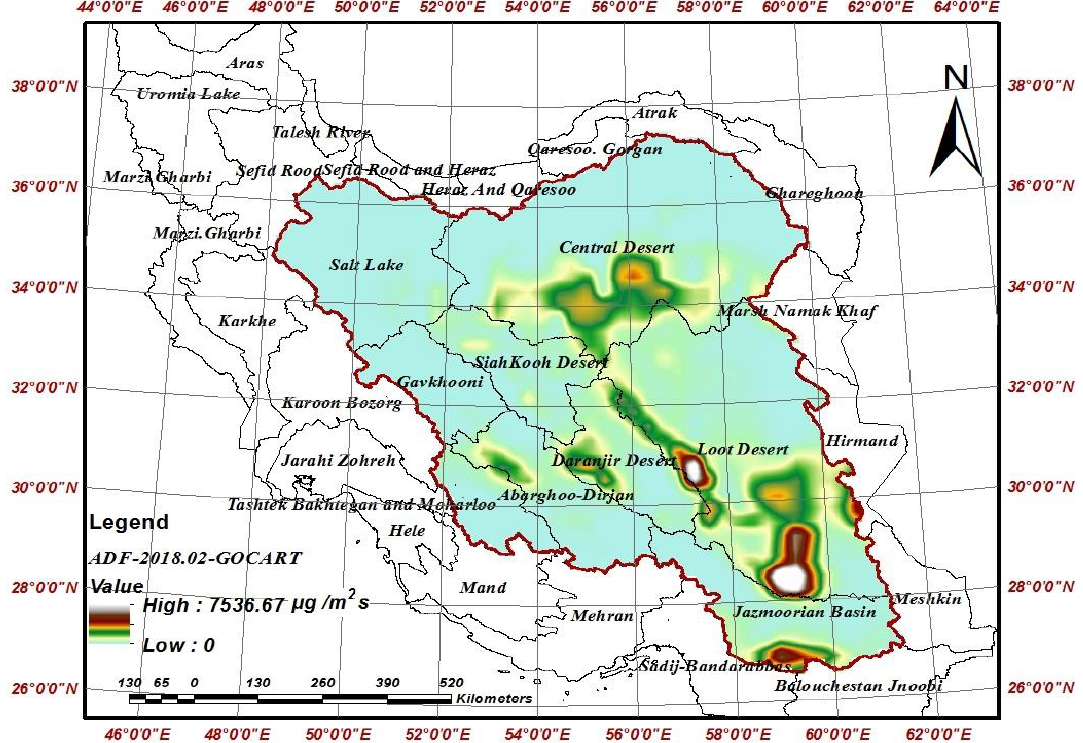
Figure 9. Average Storm Dust flux ( µ g / m 2 s) pattern on 14 February 2018 with GOCART Scheme.